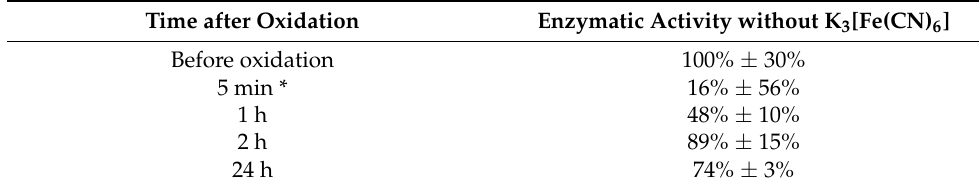
All data were measured three times and shown with standard deviation. Asterisk (*): one time was measured from a different lot and scaling by the activity of [Before